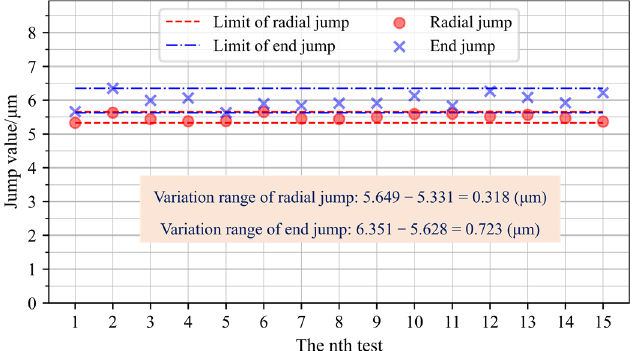
Figure 15. Test results of experimental group 3 without rotating teeth.